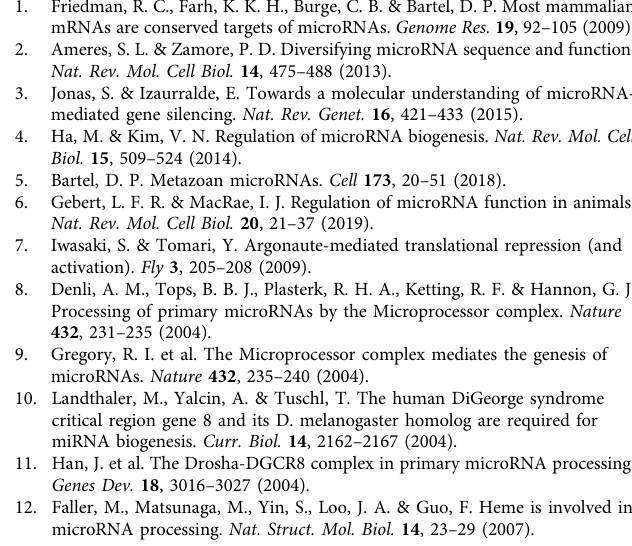
Table 8. For small RNA sequencing, 9µg of plasmid mixture was transfected into HCT116 cells seeded in a 100 mm-dish using Lipofectamine ™ 3000. The components of the plasmid mixture are listed in Supplementary Table 9. Total RNAs were extracted using TRIzol reagent (Invitrogen). Small RNA sequencing libraries of the transfected HCT116 cells were generated using the TruSeq Small RNA Library Prep Kit.